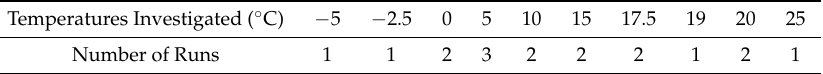
Table 1. Temperatures investigated and number of runs